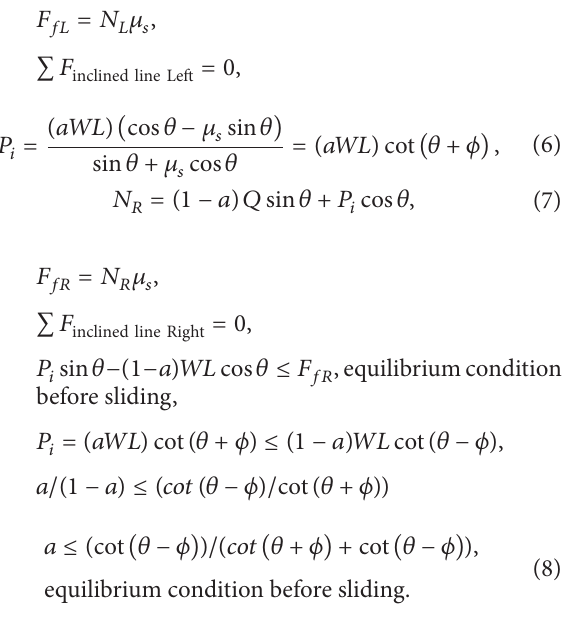
Figure 7: Simplification model of beam movement with nonsym-